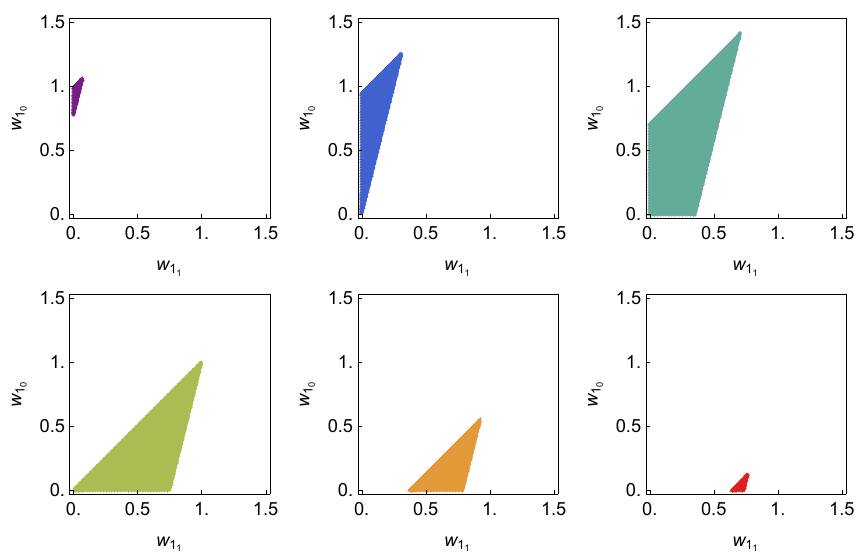
Figure 9. Solution spaces for w α , as shown in terms of ( w 1 figure 8; see discussion in text.